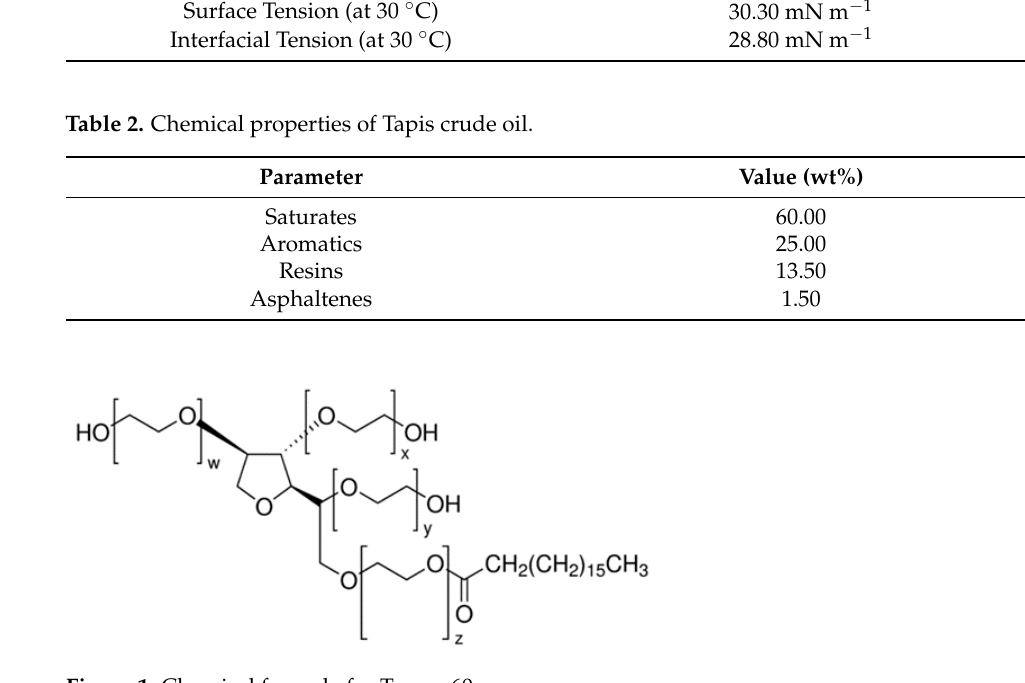
Figure 1. Chemical formula for Tween 60.